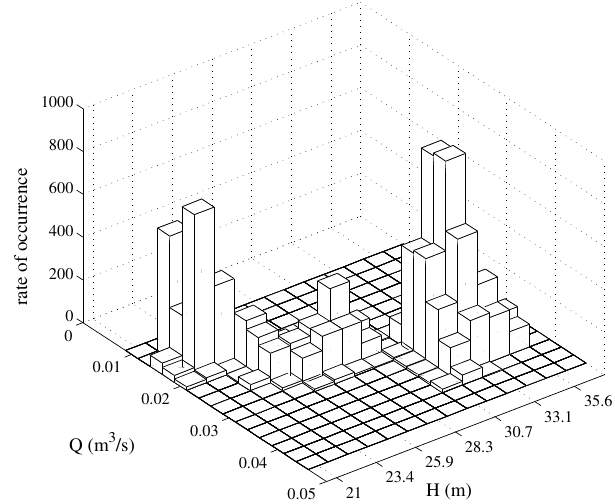
Figure 3. Histogram with the rate of occurrence of H and Q .